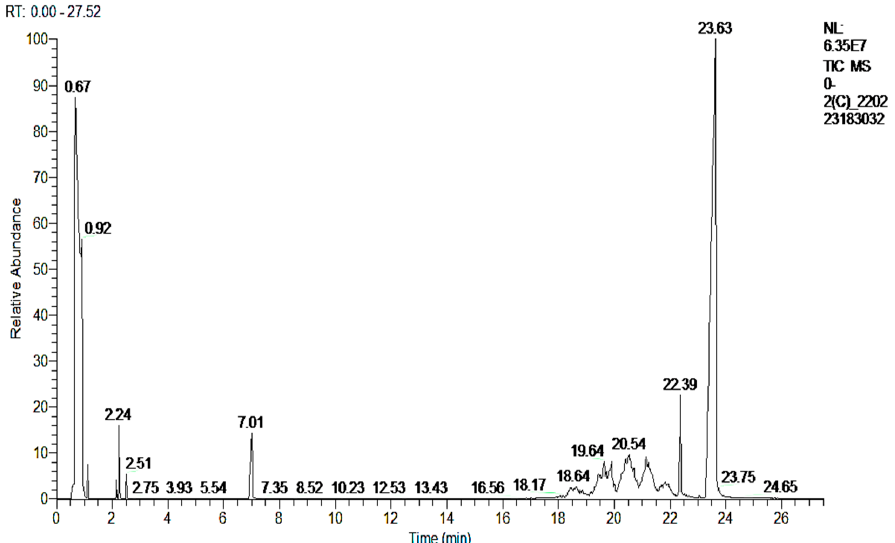
Figure 7. GC chromatogram of orange II after B. subtilis degradation. Table 4. Identified metabolites in degraded dye mixture from GCMS results.